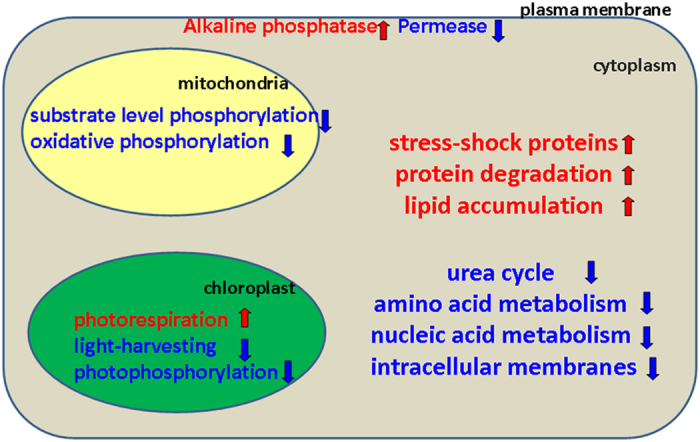
Metabolic responses of P. tricornutum under –P stress.The up and down arrows indicate the upregulated (red) and downregulated (blue) metabolic pathways, respectively.